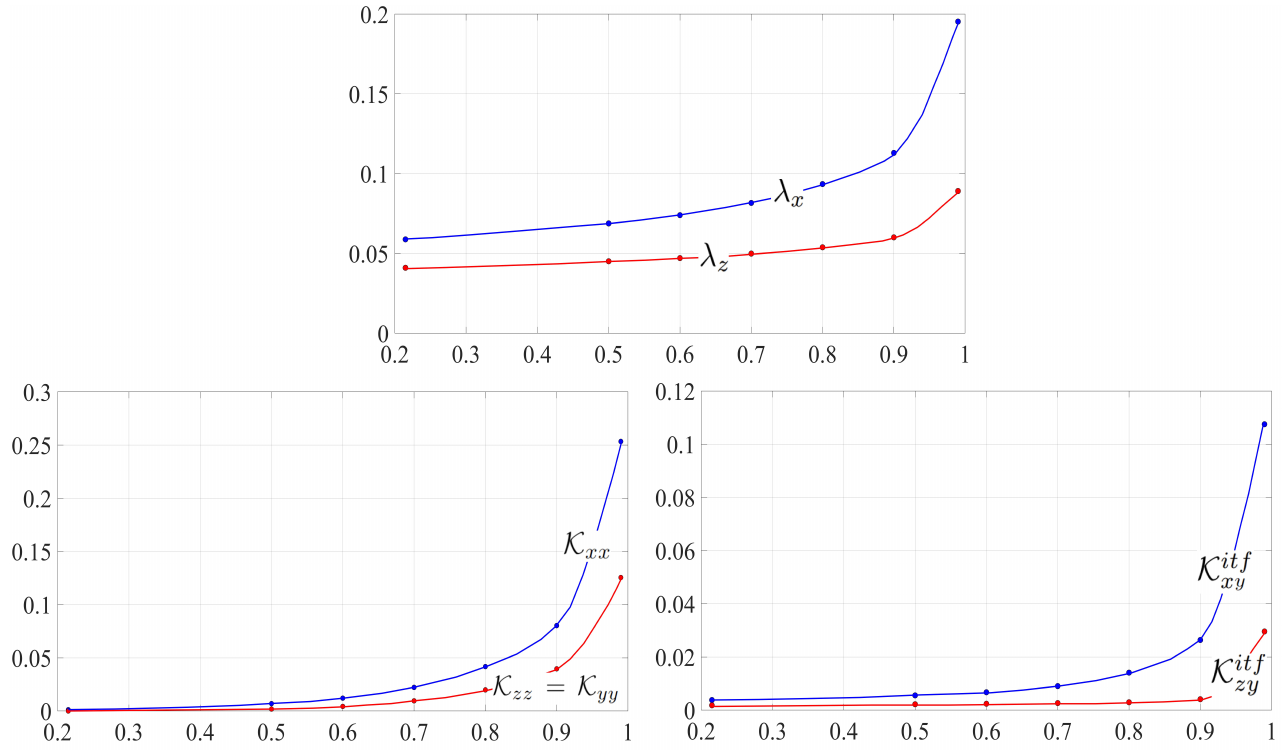
Figure 4. Variation of the model coefficients (Table 1) against porosity ( θ